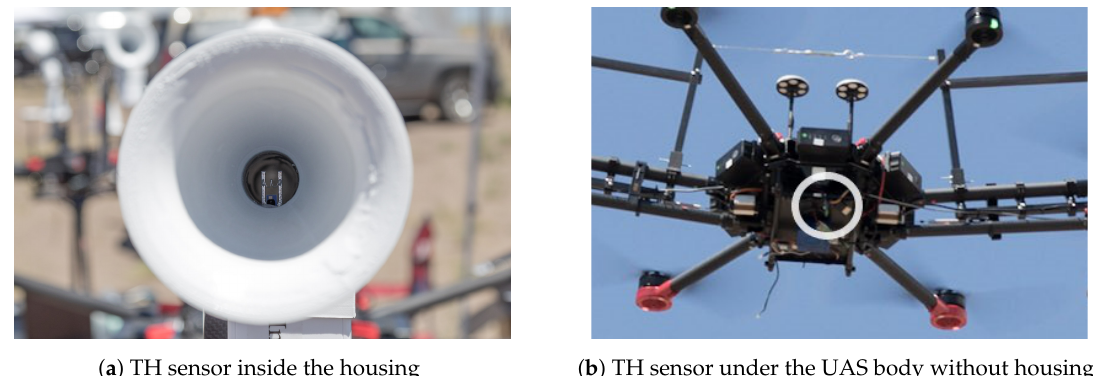
Figure 3. The sensor configurations used in the experiments for this paper: The sensor without housing is mounted without any additional radiation